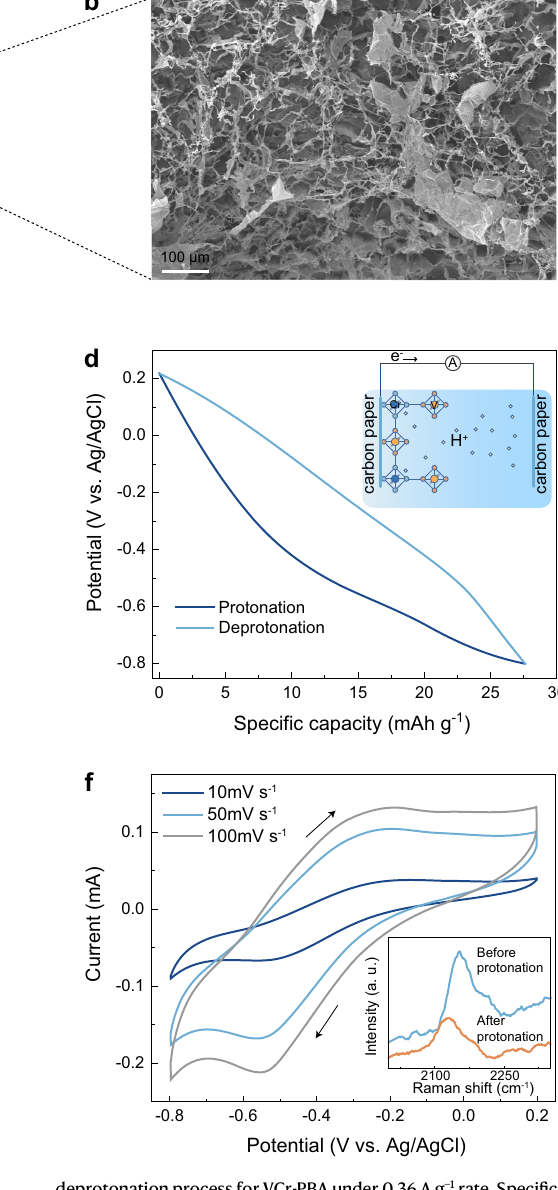
deprotonationprocessforVCr-PBAunder0.36Ag − 1 rate.Speci fi ccapacity=current ×time/mass. e NyquistplotsforVCr-PBAatvariousprotonationlevels.Z ’ isthereal part and Z ” is the imaginary part. R s represents the high-frequency series resistor, R ct represents the charge-transfer resistance. CPE is the constant phase element that represents surface capacitance. f Cyclic voltammetry curve for VCr-PBA at 10, 50, and 100mVs − 1 . Inset shows the protonation-induced change in the Raman spectra of VCr-PBA. Source data are provided as a Source Data fi